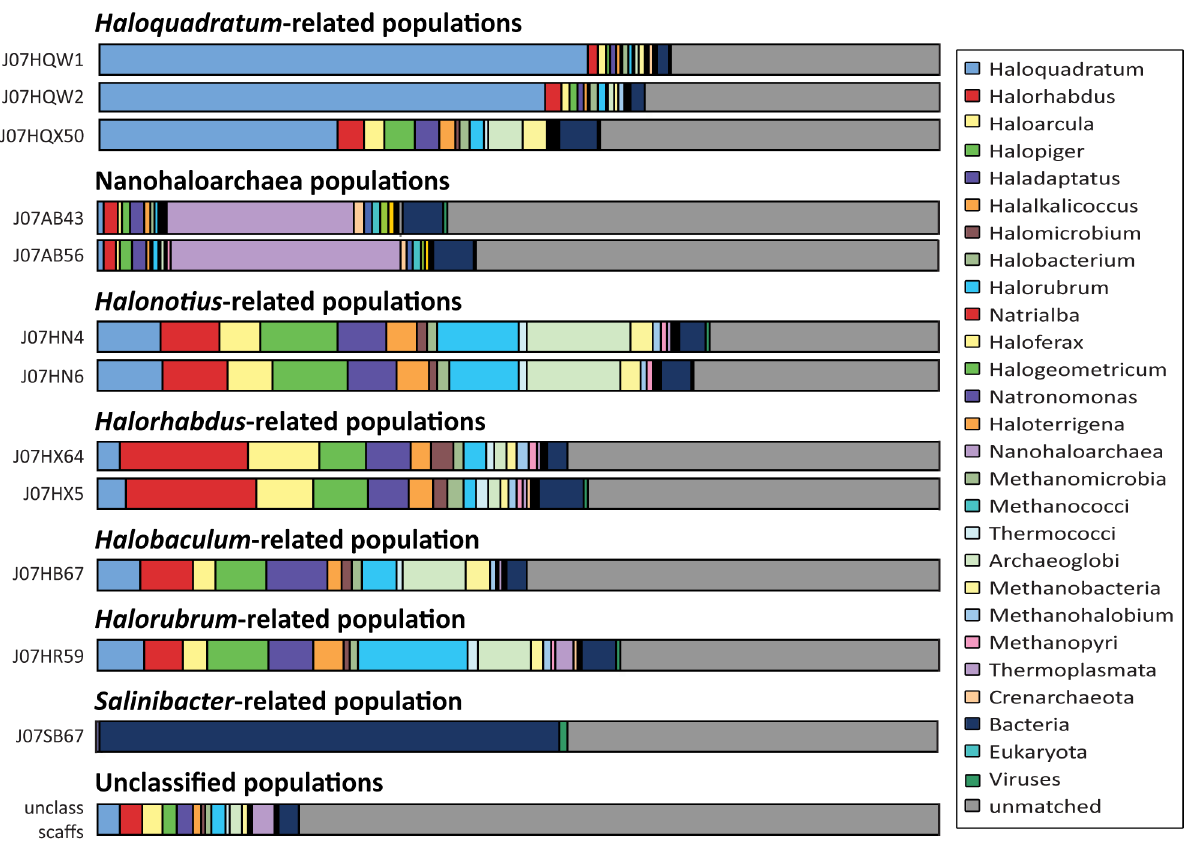
Figure 4. Phylogenetic distribution of protein BLAST matches for assembled population genomes and unclassified scaffolds. Taxonomic distribution of non-self matches versus the Genbank nr database were calculated using the DarkHorse algorithm at a filter threshold setting of 0.05, including only alignments covering at least 70% of both query and target sequences with an e-value of 1e-5 or better.